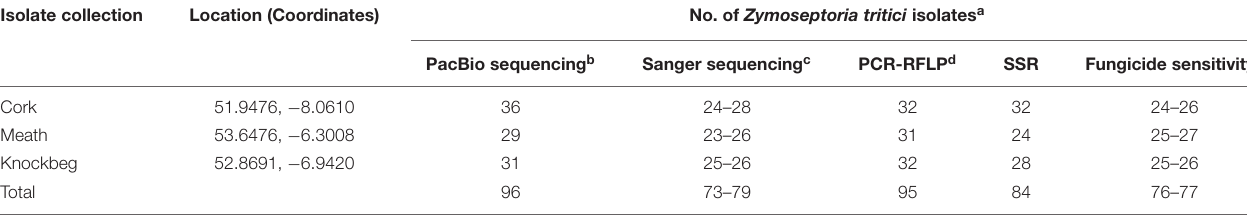
TABLE 1 | Number of Zymoseptoria tritici isolates included in each assay.